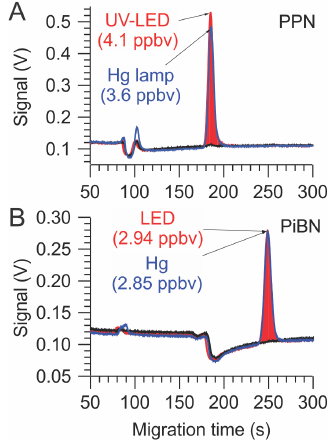
Figure 4. Comparison of UV-LED and Hg lamp output of (a) PPN and (b) PiBN.